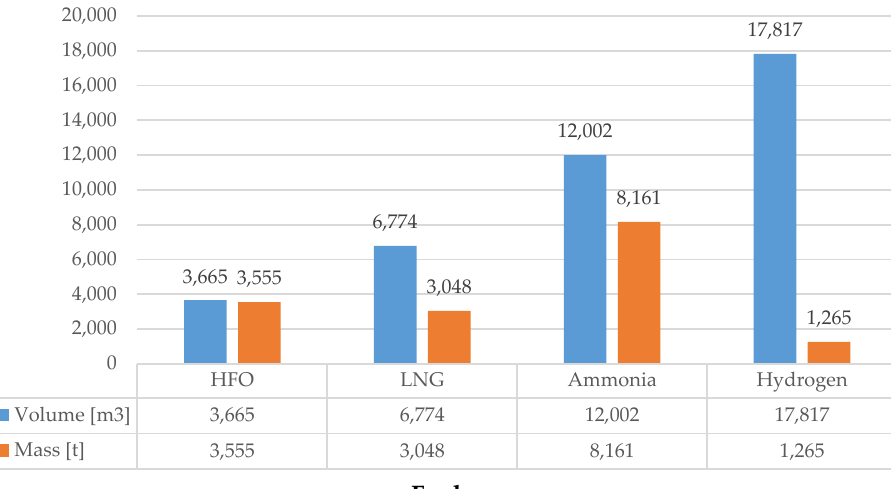
Figure 4. Comparison between fuels in terms of volumes and masses with equal energy stored on board.